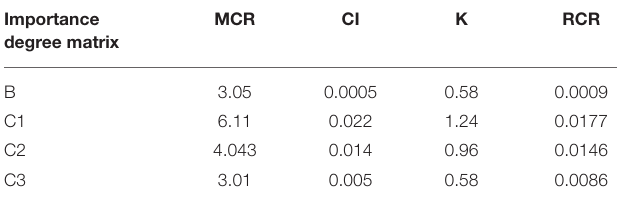
TABLE 3 | The distribution of importance degree matrix